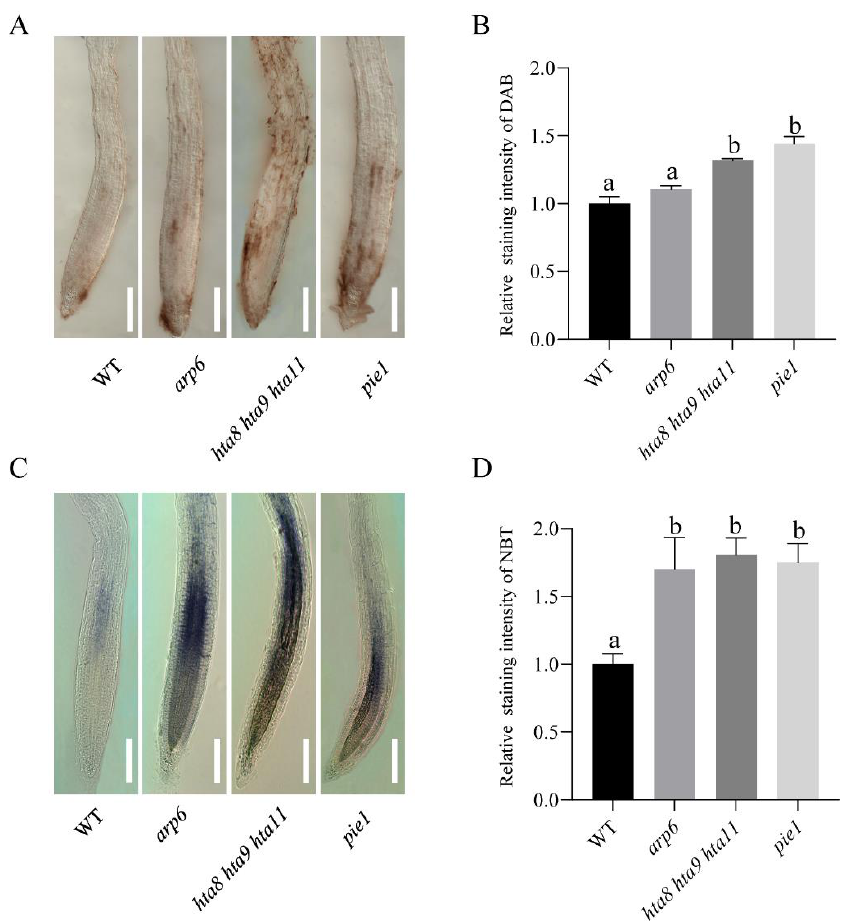
Figure 4. ROS distribution in the roots of 10-day WT, arp6 , hta8 hta9 hta11 , and pie1 : ( A ) DAB staining for H 2 O 2 in primary root, bar = 100 µ m. ( B ) Quantification of DAB staining intensity. The error bars indicate ± SD ( n > 10 seedlings). Asterisks indicate significant differences for comparisons based on Student’s t test (* p < 0.05). ( C ) NBT staining for O 2 − in primary root, bar = 100 µm. ( D ) Quantification of NBT staining intensity. The error bars indicate ± SD ( n > 10 seedlings). Different letters above the columns indicate significant differences at p < 0.05, as determined by one-way ANOVA.